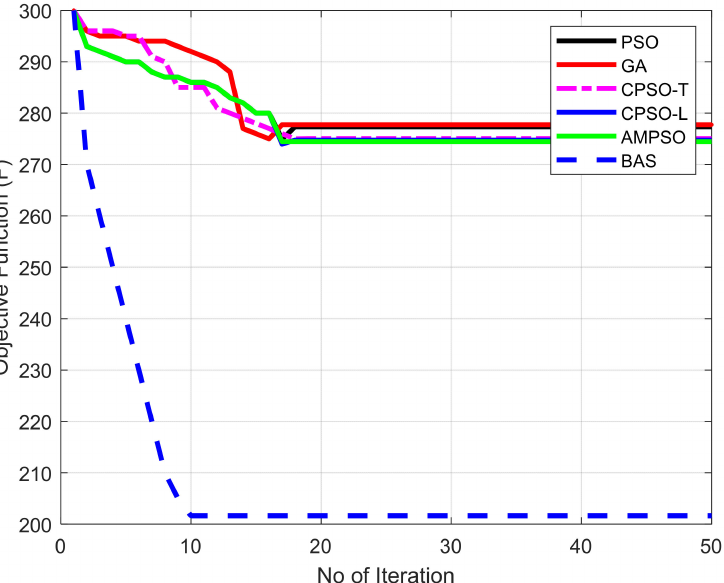
Figure 10. Comparison of convergence characteristics of the objective function with different algorithms.